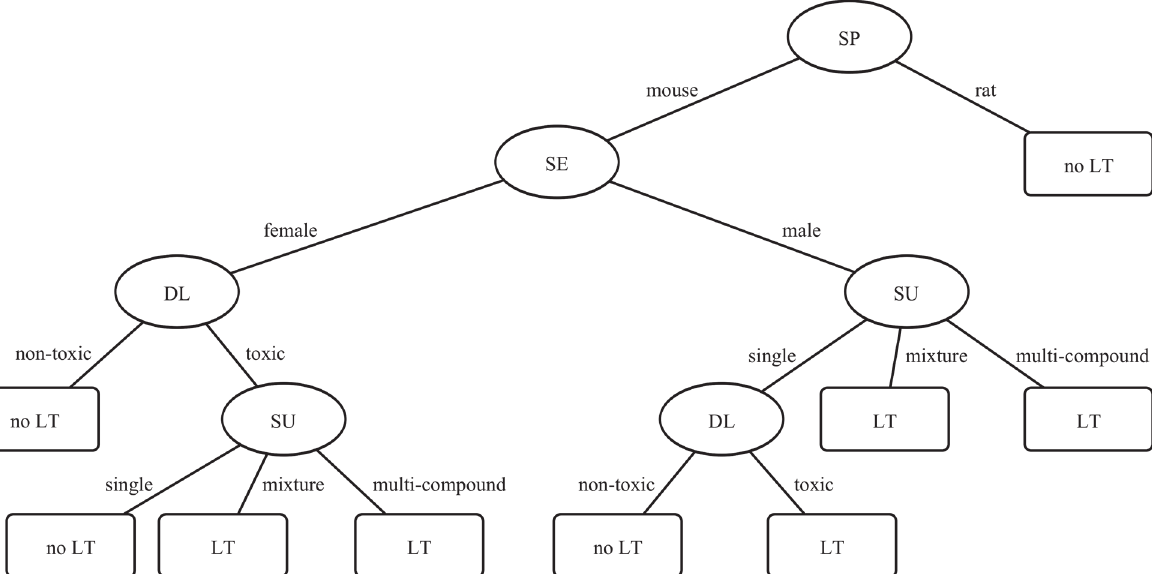
Figure 1. Decision tree to predict liver tumors. The tree was learned using the C4.5 algorithm. It predicts liver tumors (LT) with information about the animal (SP = species, SE = sex), specifications on the 2Y-CS (SU = substance), and an indicator for liver toxicity extracted from the dose finding study (DL = dose